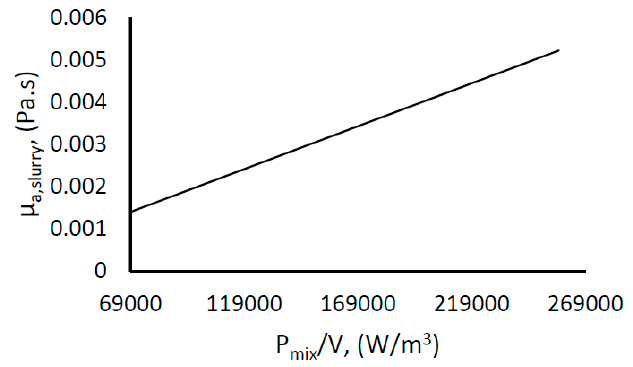
Figure 7. Estimated viscosity during hydrate growth.